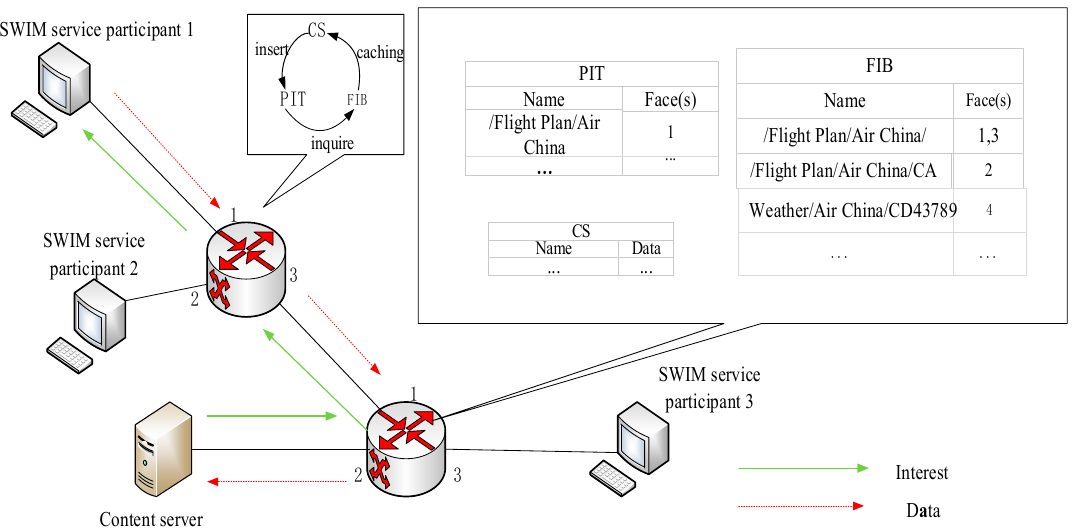
Figure 7. The name-based data forwarding process in Figure 7. The name ‐ based data forwarding process in SWIM.